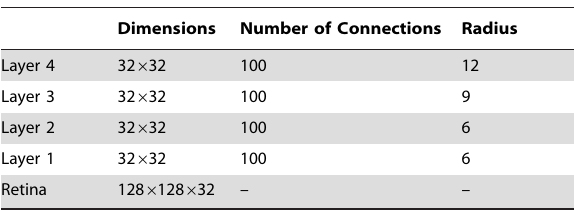
Table 1. Network dimensions.